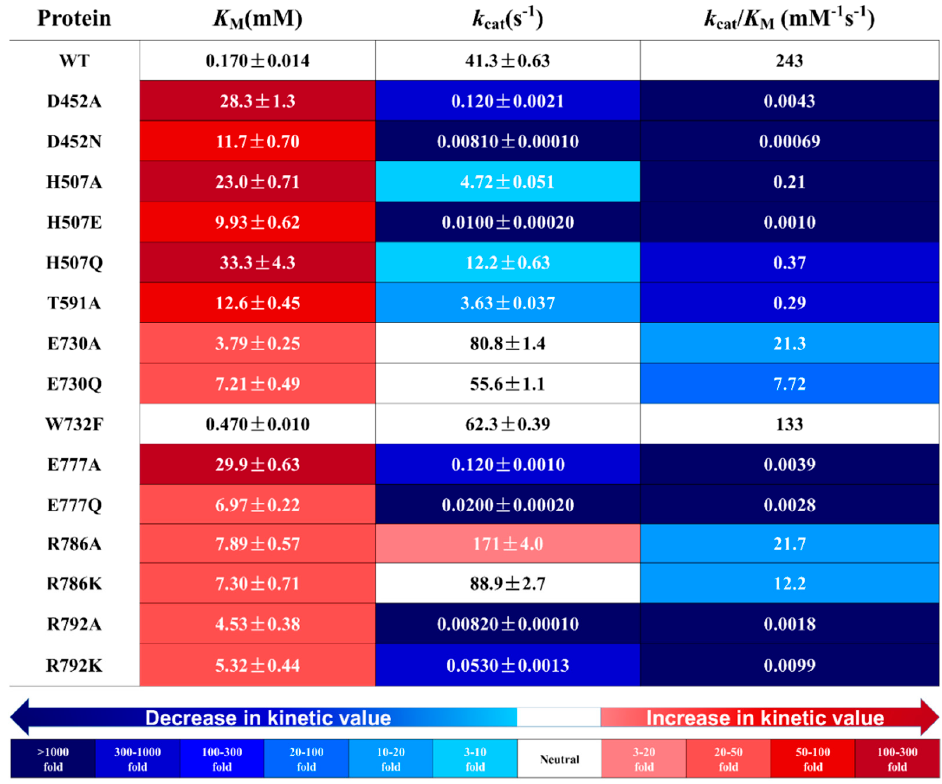
Figure 3. Kinetic constants of the Tx GH116 wild type (WT) enzyme and mutants with p NPGlc substrate. The heat map represents the fold changes in the apparent k cat , K M , and k cat / K M values of each mutant relative to the WT enzyme. Red represents different fold increases and blue represents different fold decreases (from light to dark). Values in white boxes are within a factor of 3 of those for WT.